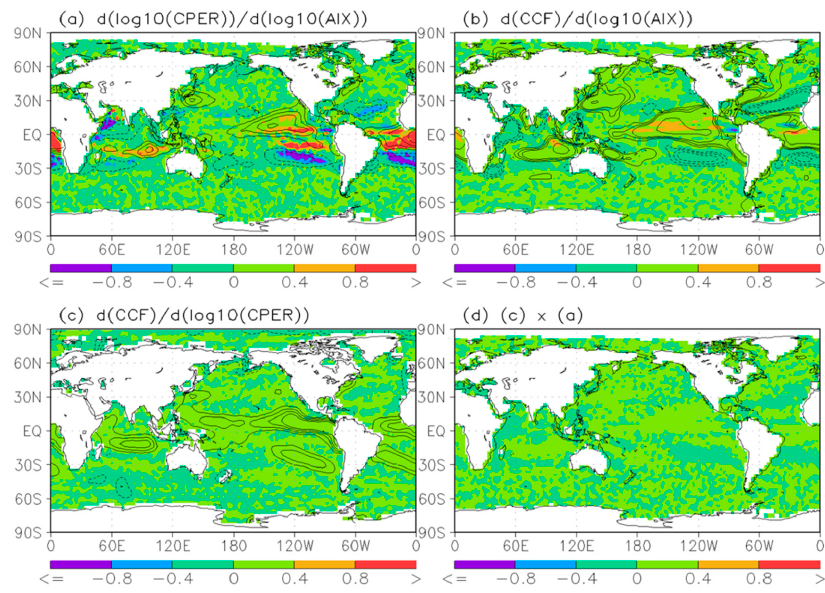
Figure 9. Global distributions for the sensitivity of ( a ) CPER relative to AIX, ( b ) CCF relative to AIX, ( c ) CCF relative to CPER, and ( d ) the product of ( a , c ).